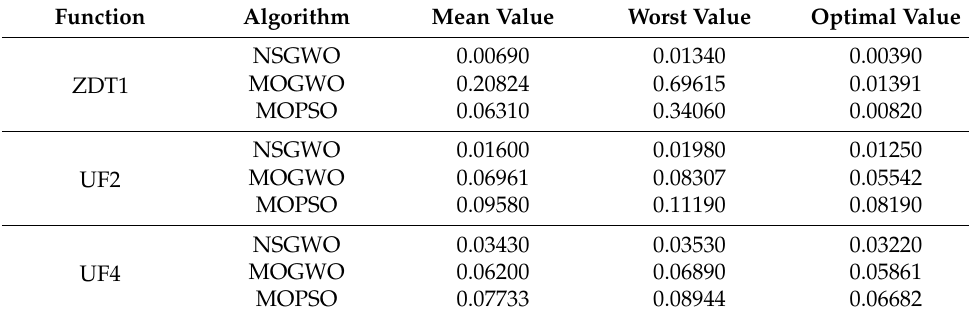
Table 3. IGD values of optimization results for benchmark functions.